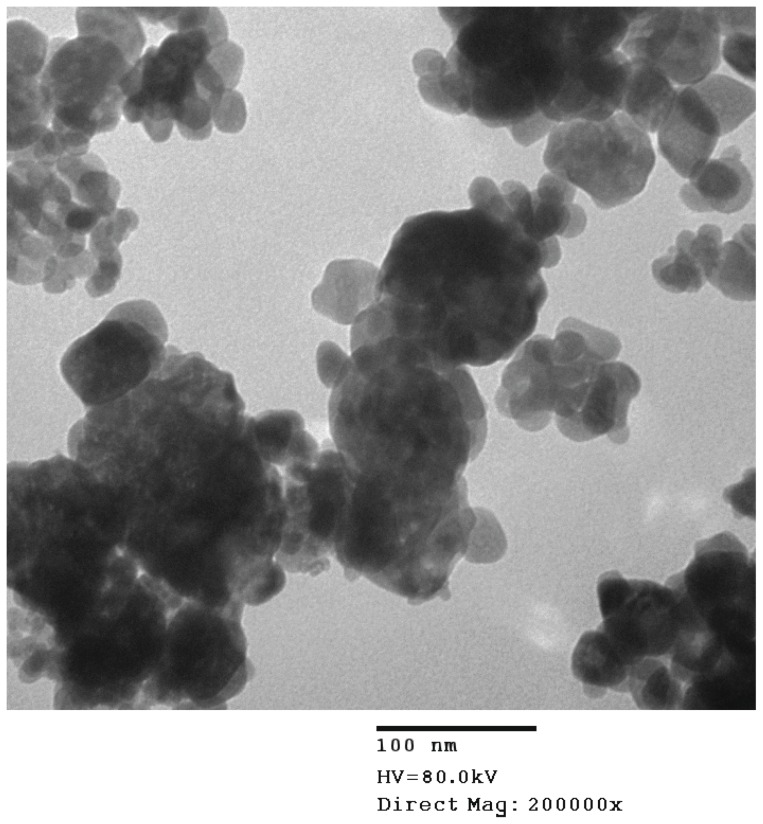
The transmission electron microscope (TEM) image of nFe2O3 aggregates (10 mg/L) in zebrafish culture medium.